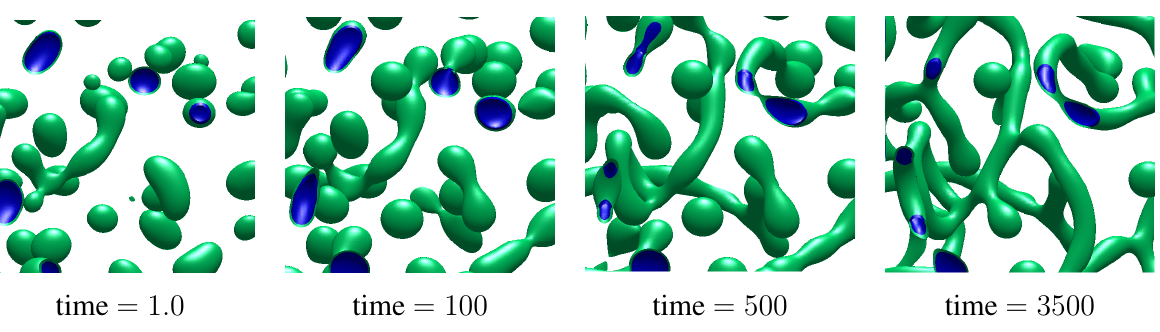
. 4 , E = 1 , η = η = 2 (cid:15) . b h m −